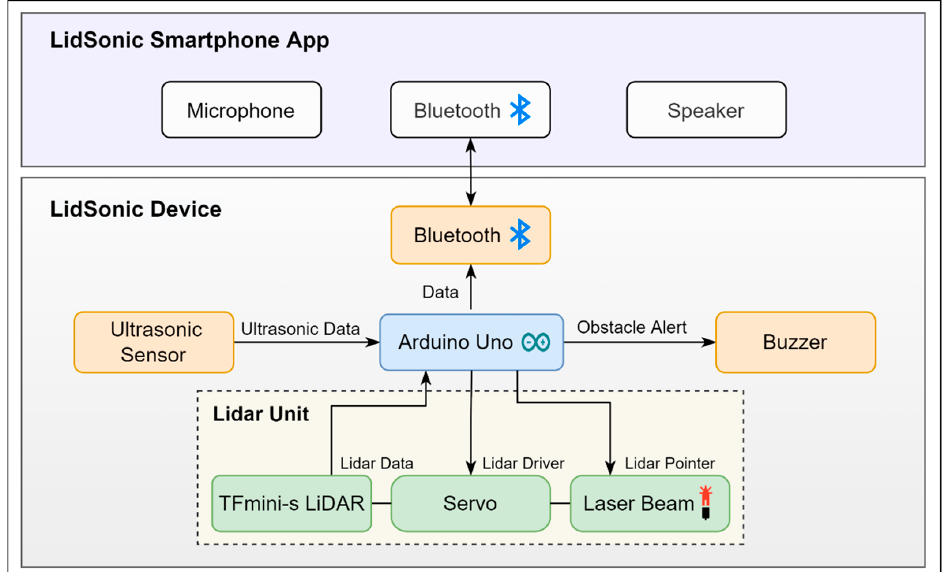
Figure 6. A hardware view of the LidSonic system.